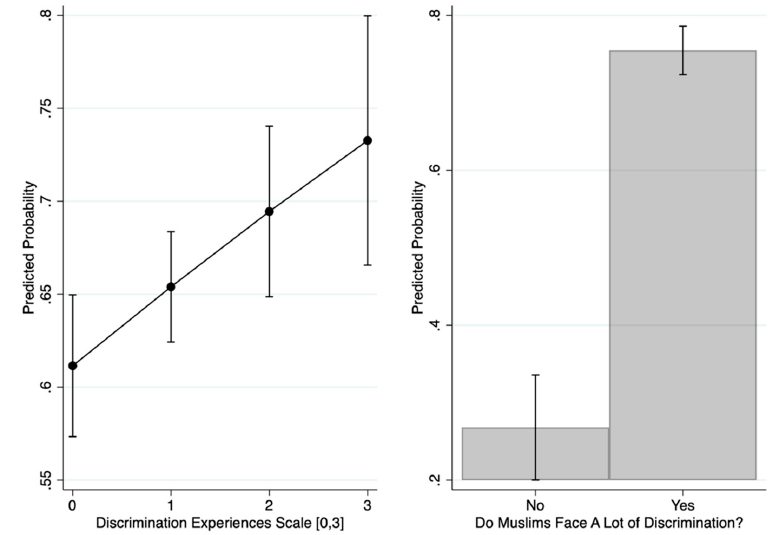
Figure 4. Predicted probability of perceiving discrimination against gays and lesbians, computed from models 3 (left) and 4 (right) of Table 3, which utilize the 2017 data and include controls for age, gender, ethnicity, generation, income, mosque attendance, frequency of prayer, and political